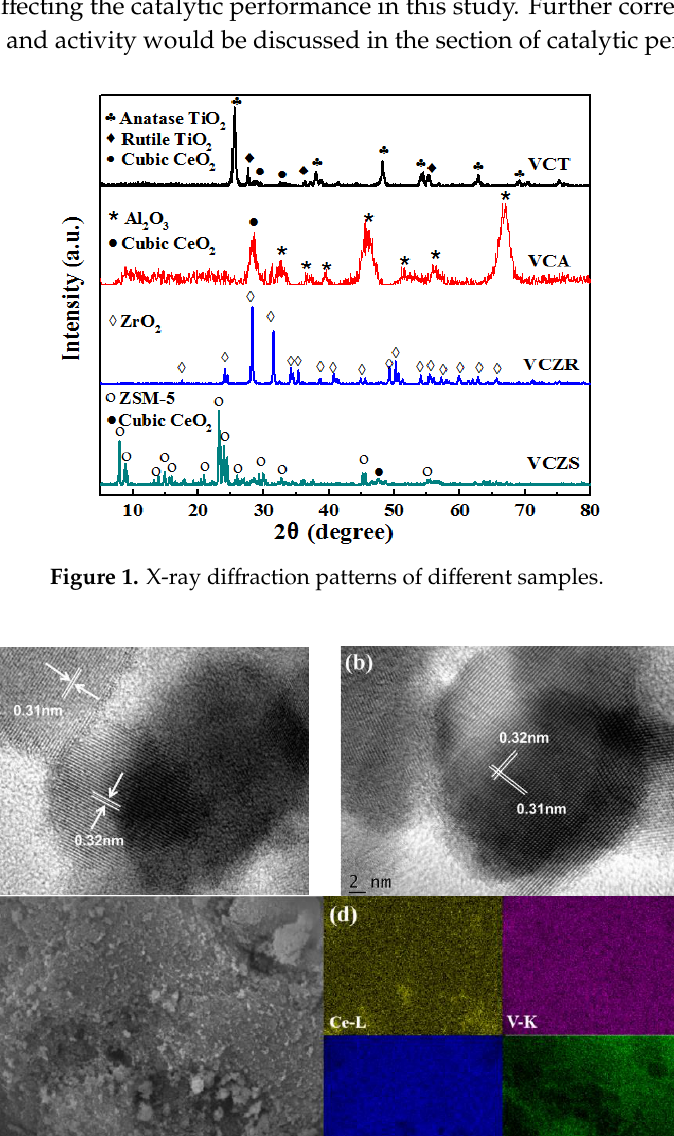
Figure 1. X-ray diffraction patterns of different samples.